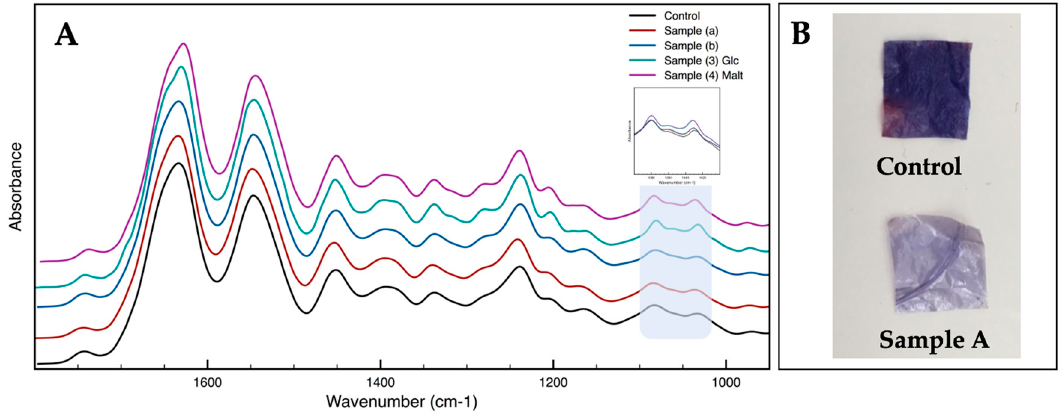
Figure 2. ( A ) FT-IR spectra of collagen samples; ( B ) Ninhydrin assay.